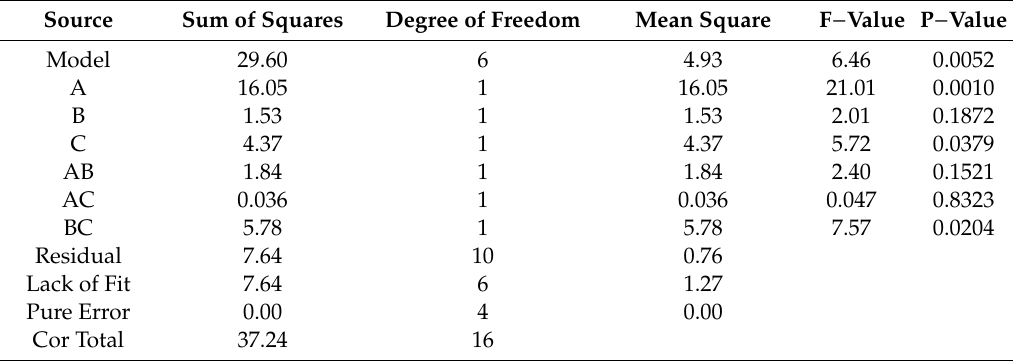
Table 5. ANOVA (analysis of variance) of quadratic model of q e